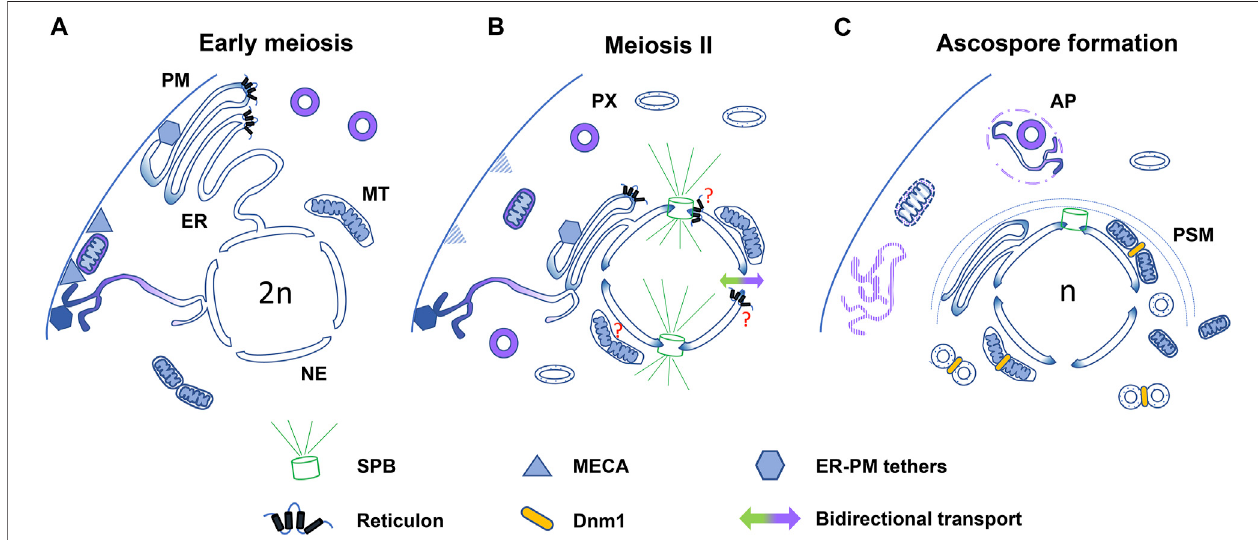
FIGURE 2 | Model for organelle dynamics during fungal meiotic development. Diagram summarizing different processes involved in the regulation of organelle dynamics in different fungi. (A) In early meiosis, in S. cerevisiae , mitochondria (MT) and cortical ER are tethered to the plasma membrane (PM) through interactions with MECA (triangles) and different ER tethering proteins (hexagons with different shading), respectively. Increased mitochondrion fusion also takes place at this stage. In P. anserina, peroxisomes (PX) and reticulon (Rtn1)-rich ER domains exhibit a polarized localization. (B) Upon meiosis II (only one dividing nucleus is shown), in S. cerevisiae Ndt80-dependent transcriptional changes promote MECA degradation and ER-shaping protein-dependent detachment of the ER from the cell cortex (ER collapse). Mitochondria and most ER are relocated to the cell central area, while speci fi c tethers retain a subset of ER at the cell cortex. In P. anserina , Rtn1 relocates to the cell central area following prophase I, where it could support SPB- and/or NPC-dependent spindle dynamics. During meiosis II, peroxisomes distribute more homogeneously and adopt a more elongated morphology than those of early meiosis, and they also differ in their protein import competency (illustrated by different shading). In S. pombe , the nucleocytoplasmic barrier is transiently lost at anaphase II (bidirectional arrow). (C) During ascospore formation, SPB-driven prospore membrane (PSM) formation conducts the packaging of meiotic nuclei, portions of the ER, nuclear-associated mitochondria and peroxisomes into nascent ascospores. In S. cerevisiae , the plasma membrane-retained ER is degraded upon vacuole permeabilization, and a second subset of the ER is eliminated by ER-phagy (AP, autophagosome). Dnm1-dependent fi ssion is required for mitochondrion segregation. In P. anserina , Dnm1 is required for peroxisome segregation. Pexophagy could eliminate selected peroxisomes in P. anserina and in S. macrospora